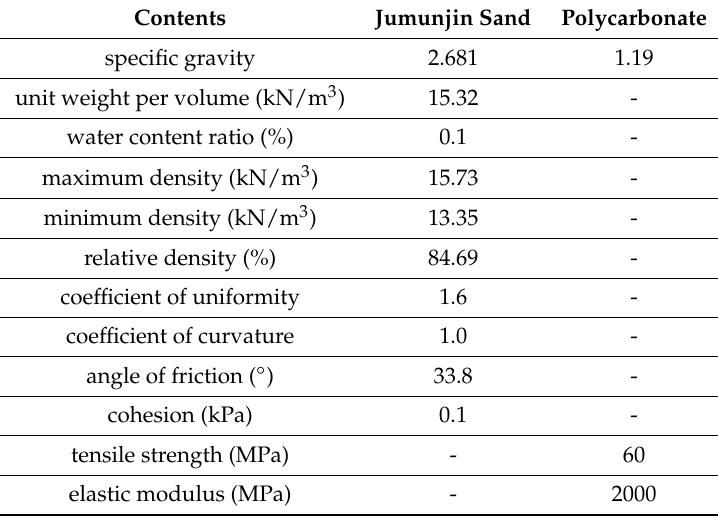
Table 7. Physical properties of Jumunjin sand polycarbonate.